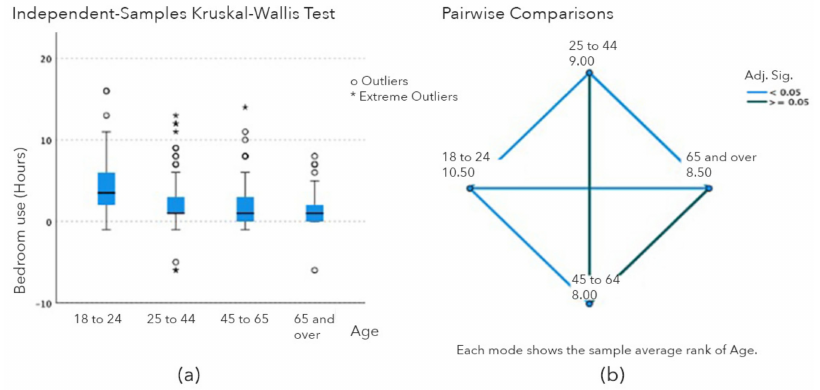
Figure 5. Analysis of the association between bedroom use and age groups: ( a ) Independent samples Kruskal–Wallis Test results; ( b ) Pairwise comparison.